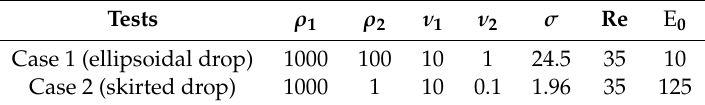
Table 1. Numerical parameters taken for the